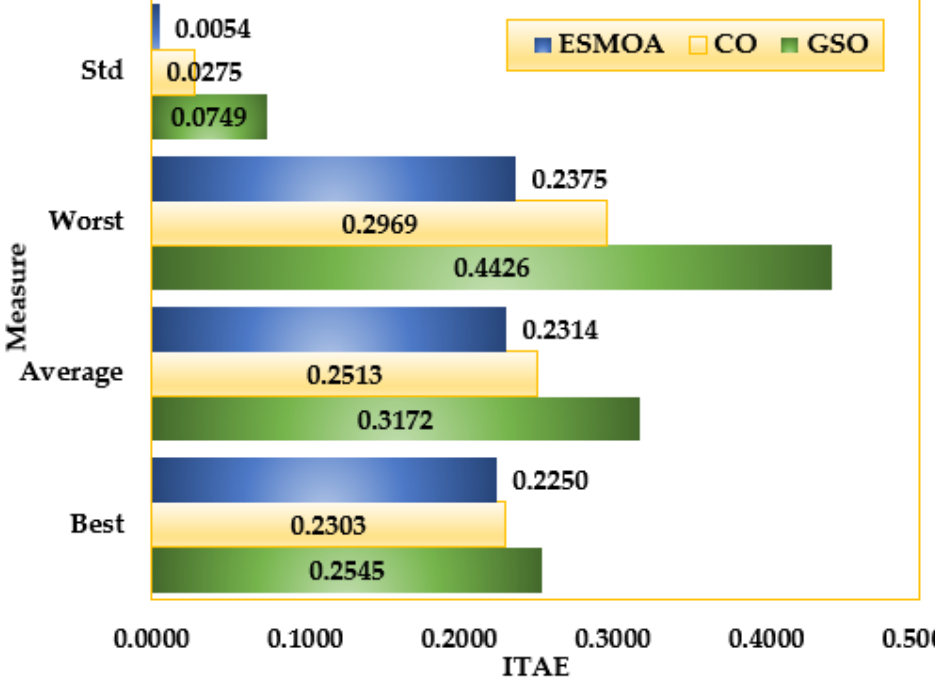
Figure 16. Statistical measures for CO, GSO, and the proposed ESMOA for Case 4.